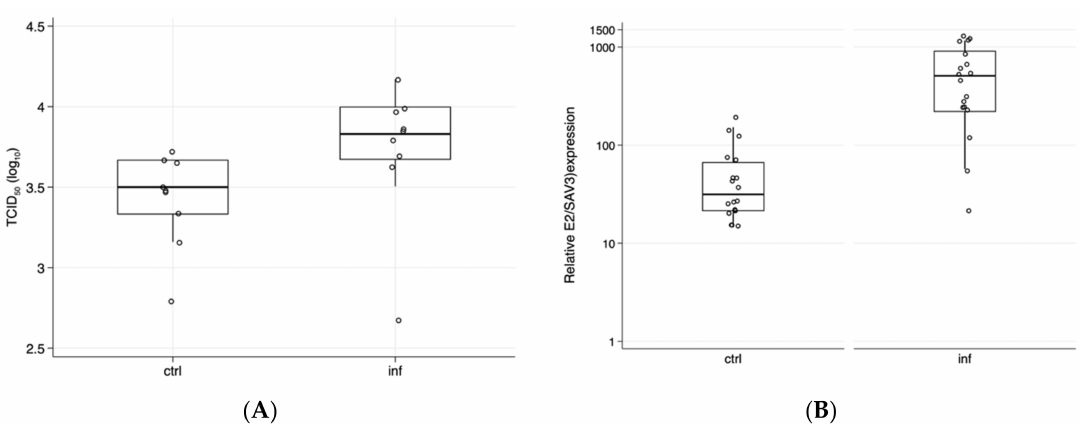
Figure 1. Replication of SAV-3 in PBMCs from non-infested and lice-infested fish. PBMCs were isolated using Percoll gradient and infected with SAV-3. Panel ( A ): Virus titers in supernatants compiled for all time points post infection. Bars represent log TCID 50 / mL ± 25 / 75% percentiles, and titers for individual cell cultures from individual fish are shown, with a significant di ff erence between groups, p = 0.016 ( n = three fish per group, sampled at three time points and combined). Panel ( B ): Relative mRNA expression of SAV-3-E2 in cells obtained from lice non-infested (ctrl) and infested (inf) fish, three fish with two parallel cell cultures and three time points combined for each of the ctrl and inf groups ( n = 18 per group, p = 0.0001). Results are shown as a normalized expression to virus uninfected cells from each fish using the ddCt method ± 25 / 75% percentiles and results for individual fish. Whiskers show the 90%